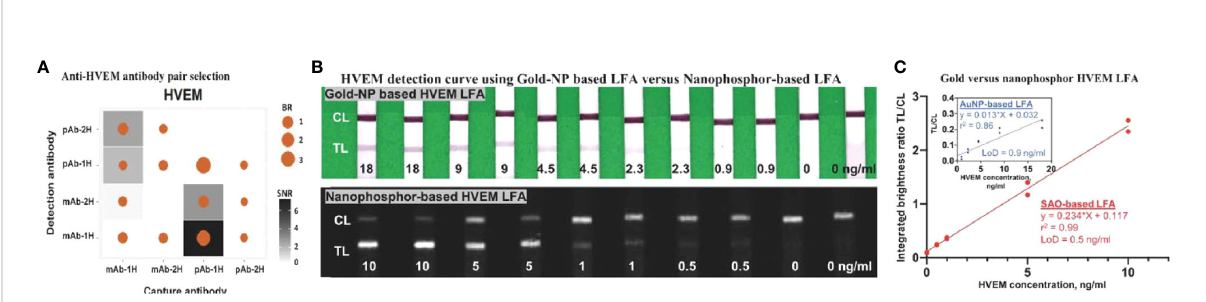
FIGURE 5 Antibody pair selection for construction of HVEM LFA and its characterization in nanophosphor-and AuNP-based LFA. (A) 13 antibody pairs (four types of antibodies) were tested for HVEM LFA performance, of which one pair (capture antibody pAb-1H paired with detection antibody mAb- 1H) showed the highest SNR and BR. (B) Scanned images of the standard curve of HVEM as assayed using AuNPs-based and nanophosphor- based LFA, and pAb-1H as capture antibody and mAb-1H as detection antibody. (C) Correlation between HVEM concentration and integrated brightness ratio as assayed using AuNPs-LFA (inside box) and nanophosphor-based LFA. pAb-1H: polyclonal anti-HVEM antibody from R&D; mAb-1H: monoclonal anti-HVEM antibody from R&D; detection Ab: the antibody conjugated onto the nanophosphors; capture Ab: the antibody immobilized onto the LFA strip; LoD, limit of detection, the lowest concentration exceeding the sum of the mean of the blanks (n=2) plus three times the standard deviation of the